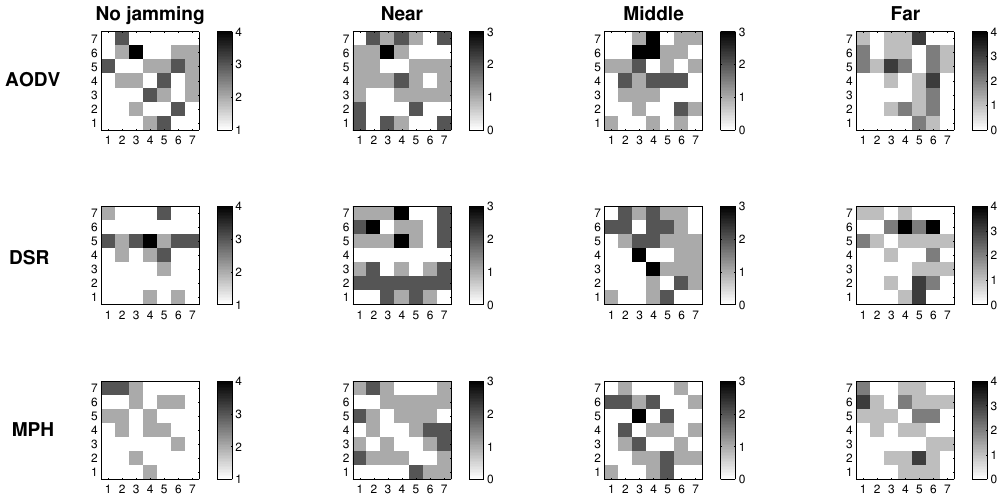
Figure 9. 2D representation of the average tries in the no jamming case and the difference between the values in the reactive and no jamming cases for each of the positions of the jammer